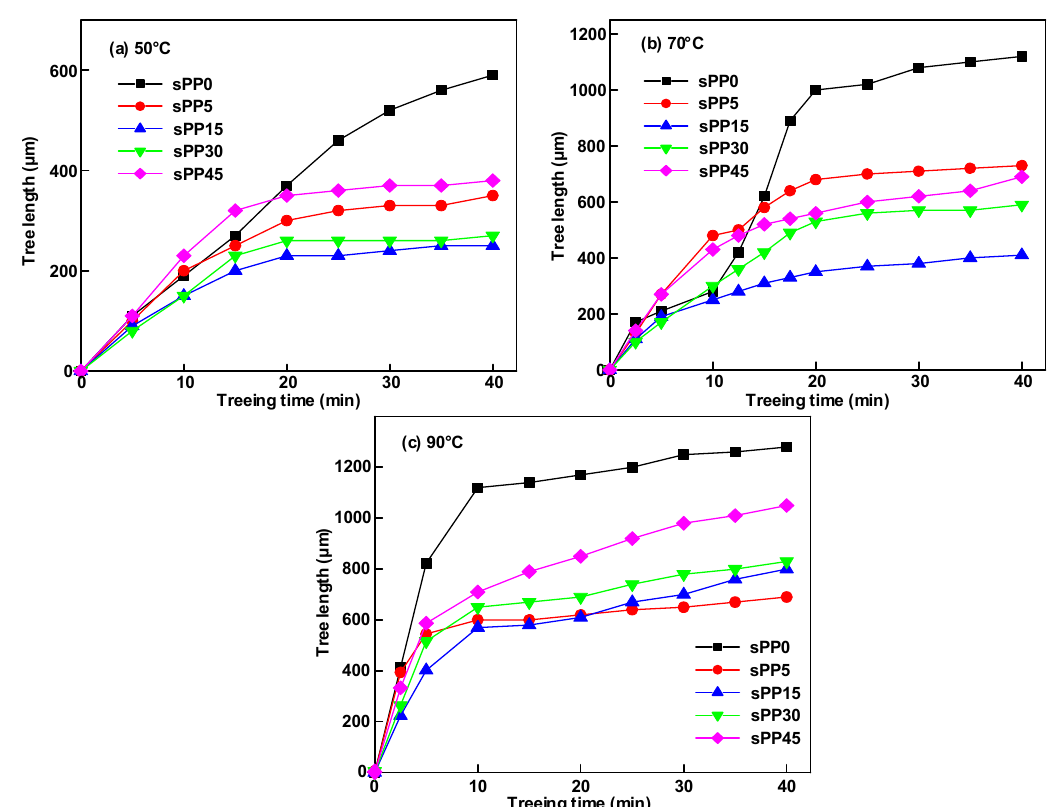
Figure 4. Variation of electrical tree length of different sPP contents at ( a ) 50 °C, ( b ) 70 °C, and ( c ) 90 °C under AC voltage of 6 kV.